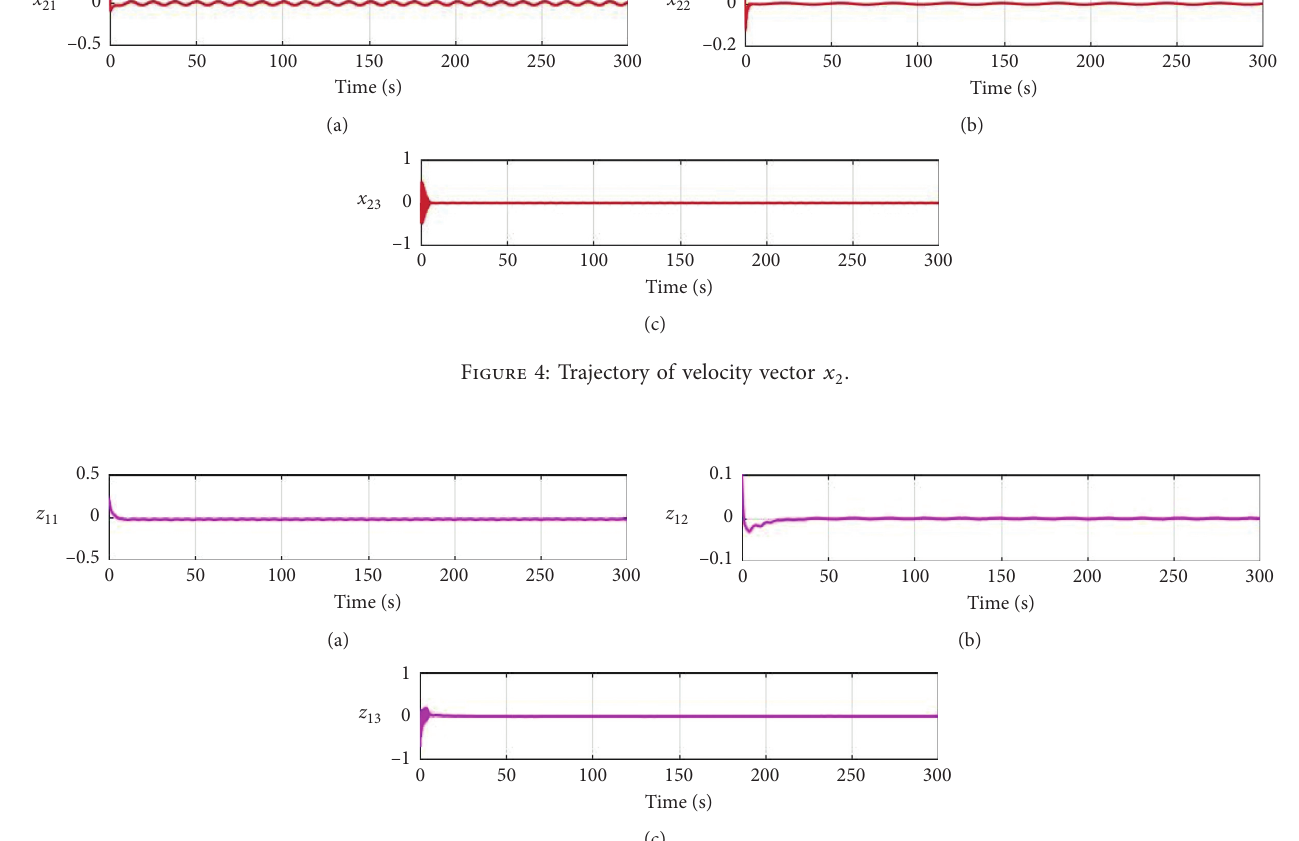
x , and constraint intervals. d 3 , 13